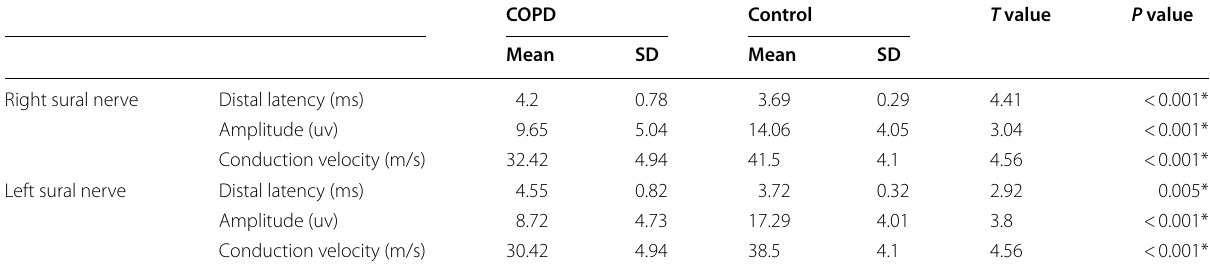
Table 5 Comparison between patient and control groups as regards to sural sensory nerve